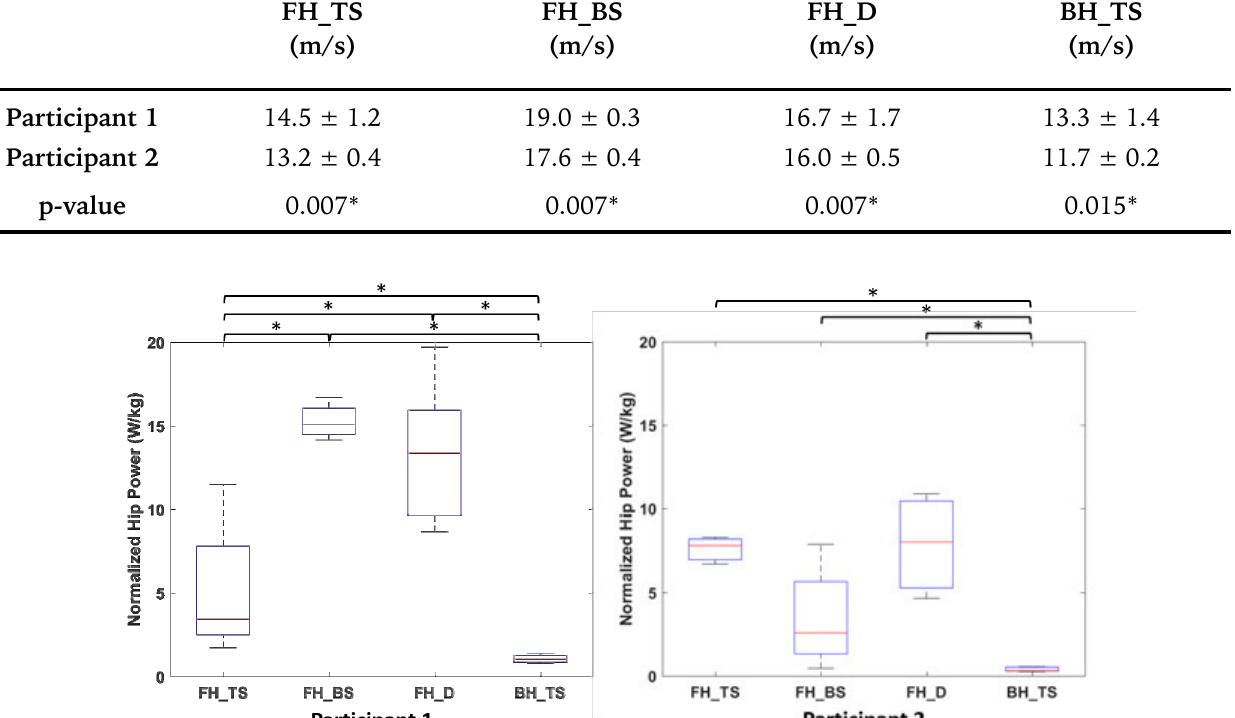
Maximal racket speed during the strike (mean ± SD) for all activities and for both participants. The * means that there were significant differences between the players.